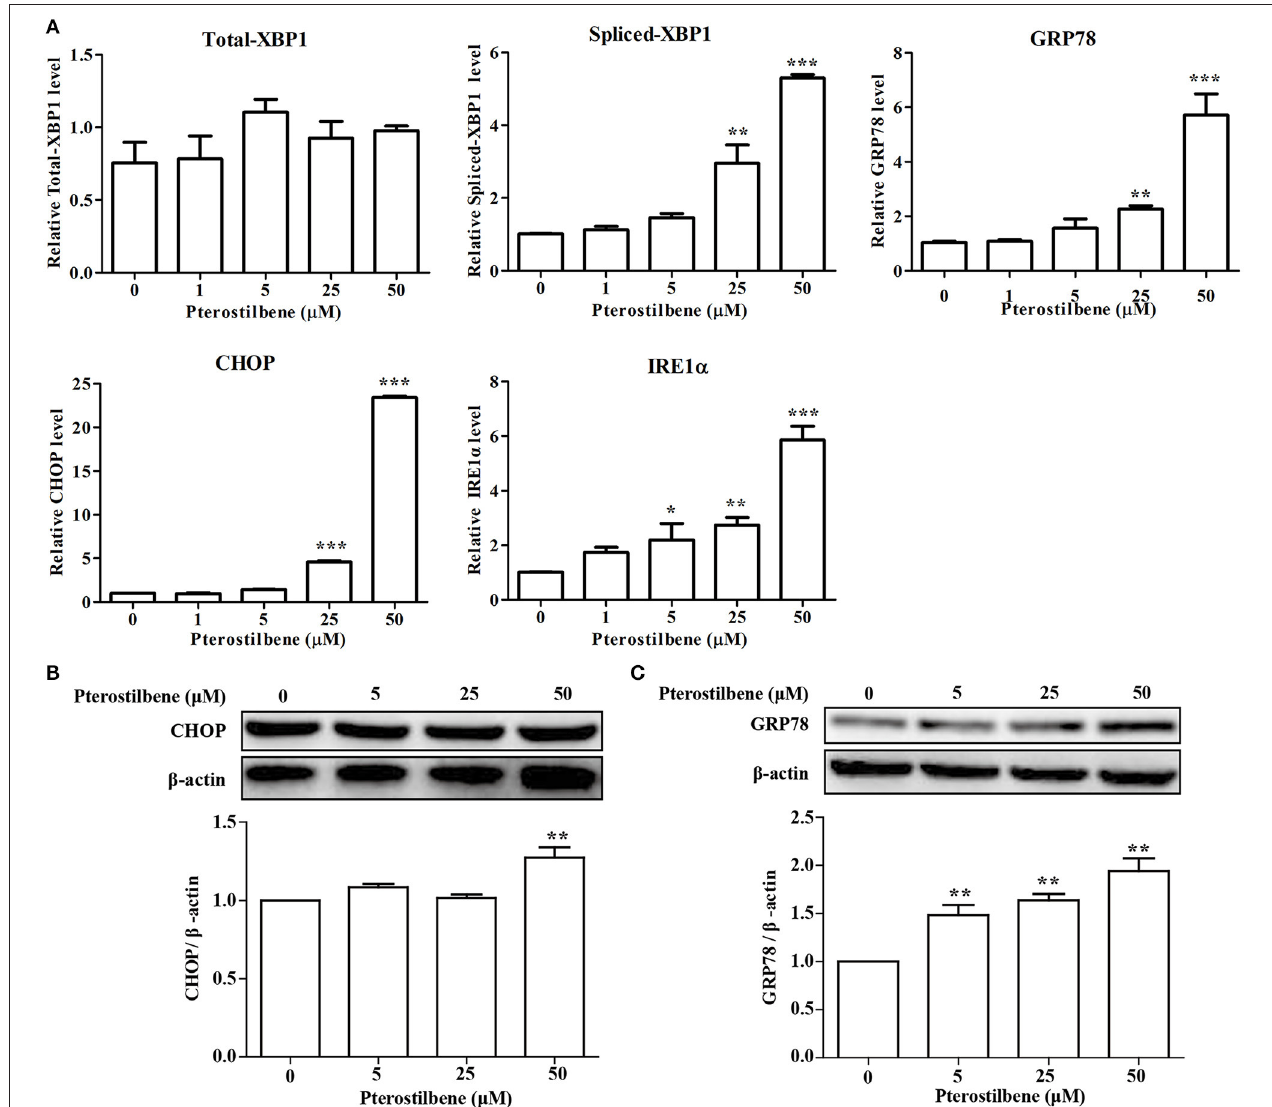
FIGURE 4 | Effect of pterostilbene on the expression of ER stress-related genes. (A) mRNA expression of ER stress-related genes; (B,C) Expression of autophagy-related genes at the protein level. Reported values are mean ± SEM. * p < 0.05, ** p < 0.01 and *** p < 0.001, indicate significant differences compared with the control